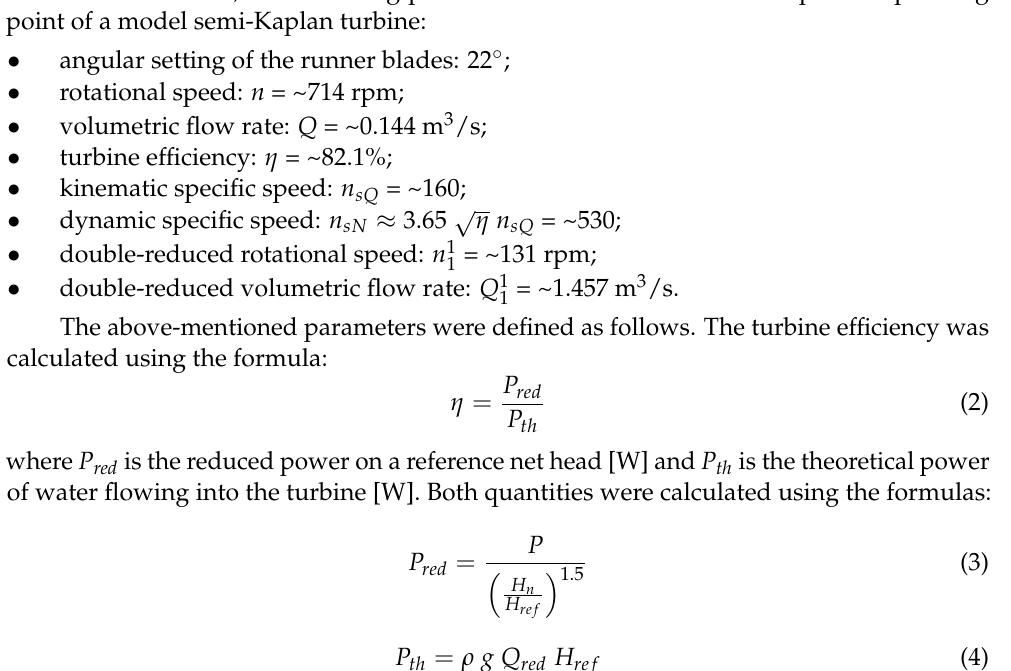
Figure 15. Curves of the double-reduced volumetric flow rate as a function of the double-reduced rotational speed for the openings of the runner blades from 8° to 38° (in 2° steps) of the semi-Kaplan model turbine.